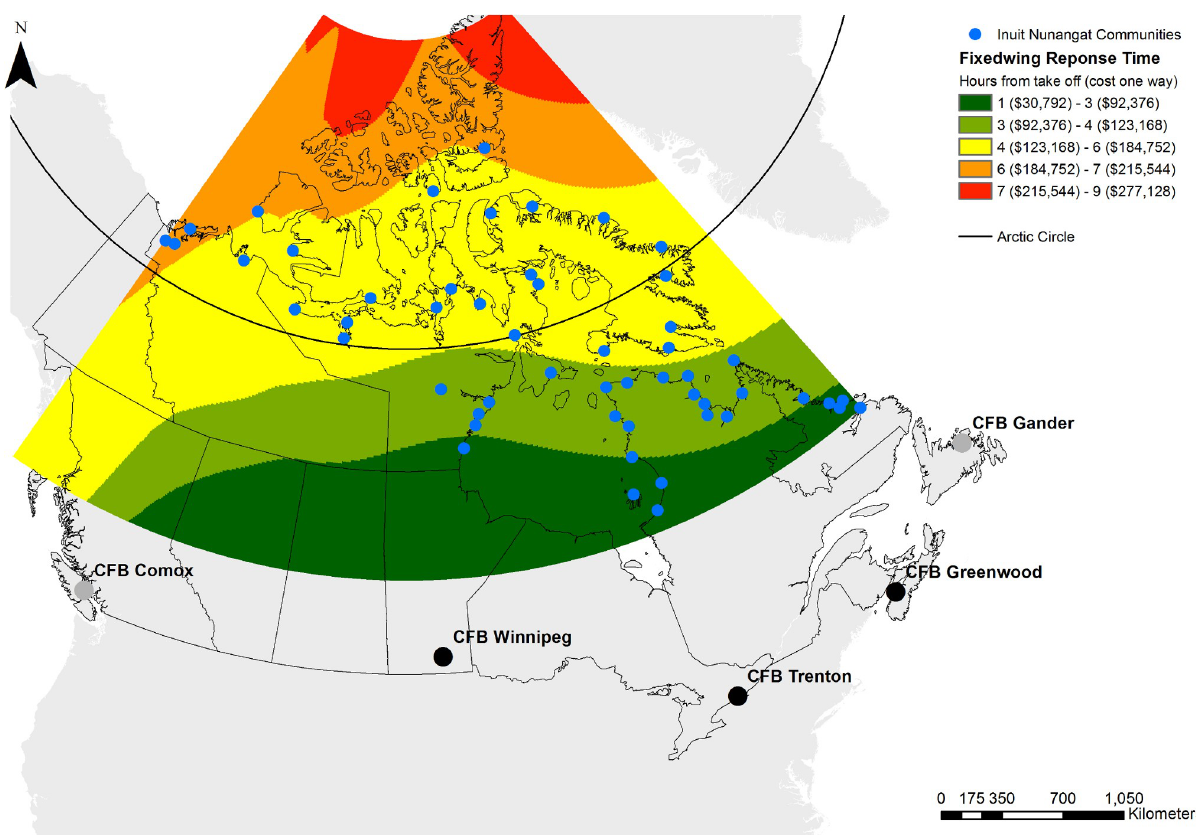
Fig 3. Royal Canadian Air Force Arctic response times and cost. Travel times for RCAF CC-130 SAR assets from takeoff to location are depicted above. RCAF has CC-130 currently at CFB Winnipeg, CFB Trenton, and CFB Greenwood. The map shows time from the closest aircraft, if aircraft were only dispatched for their zone, times in the far north would increase by roughly 2 hours. More information about calculations, as well as times for helicopter responses, can be found in the S1 File. Basemap shapefiles are modified and republished from Government of Canada under a CC BY license, with permission from Natural Resources Canada and Crown-Indigenous Relations, original copyright 2018. Contains information licensed under the Open Government License–Canada